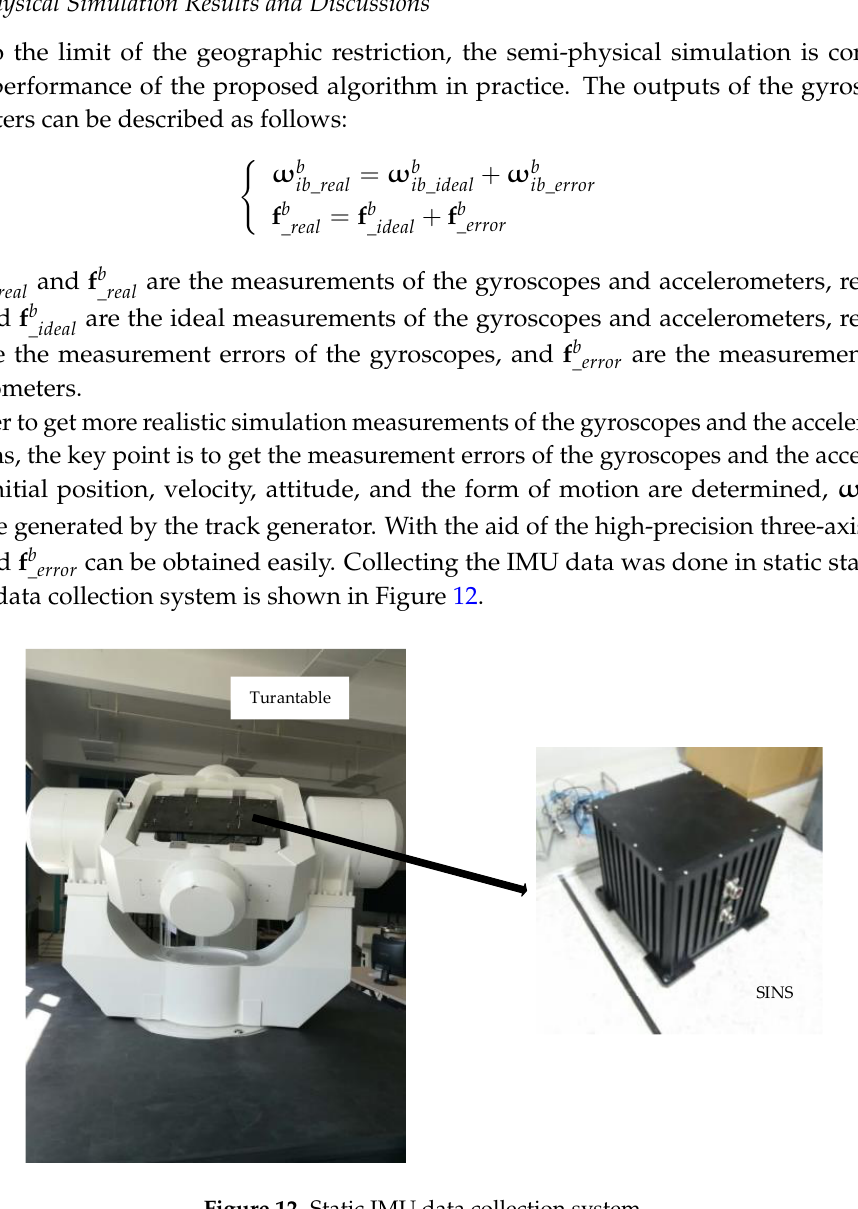
Figure 12. Static IMU data collection system.